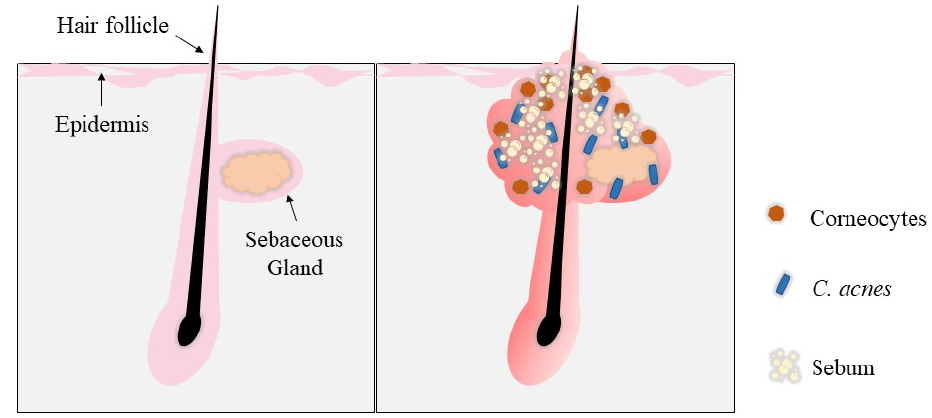
Figure 5. Acne pathogenesis in hair follicle I and comparison with normal hair follicle. Androgen hormones that are present in both men and women can also exacerbate acne by increasing sebum production and follicular development [21]. There are two types of acne lesions: noninflammatory and inflammatory lesions. Blackheads, or open comedones, are noninflammatory lesions that form because of an enlargement of the follicular plug. Whiteheads, or closed comedones, are similar except the pore remains closed. Inflammatory lesions include papules, pustules, and nodules [20]. Papules are swollen and inflamed closed comedones, whereas pustules are comedones that are inflamed to the point of rupturing into the skin. Nodules are acne lesions that have ruptured into the skin and are severely inflamed with a large, tender, and swollen appearance [19].